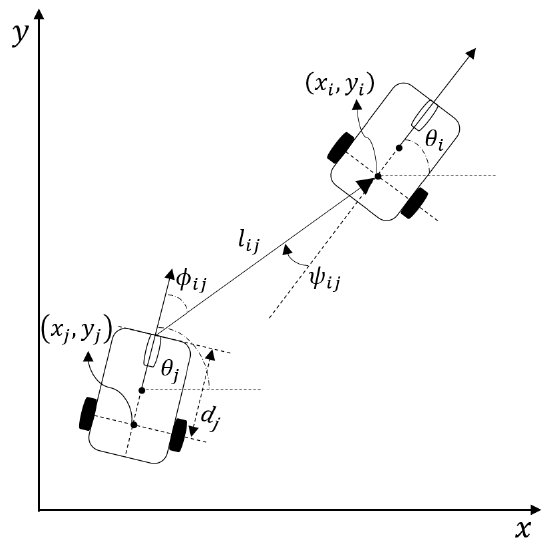
Figure 1. Leader-follower